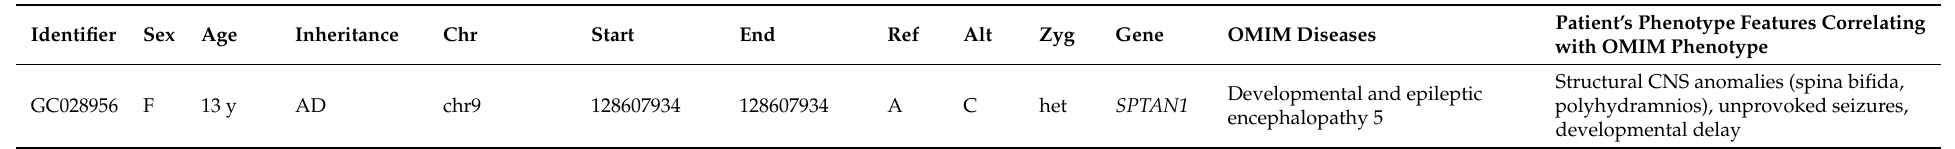
Table 3. Rare SNVs of uncertain clinical significance. CNS—central nervous system; VSD—Ventricular septal defect; IAA—interrupted aortic arch; BAV—bicuspid aortic valve; ASD—atrial septal defect; PTA—patent ductus arteriosus; DORV—double outlet right